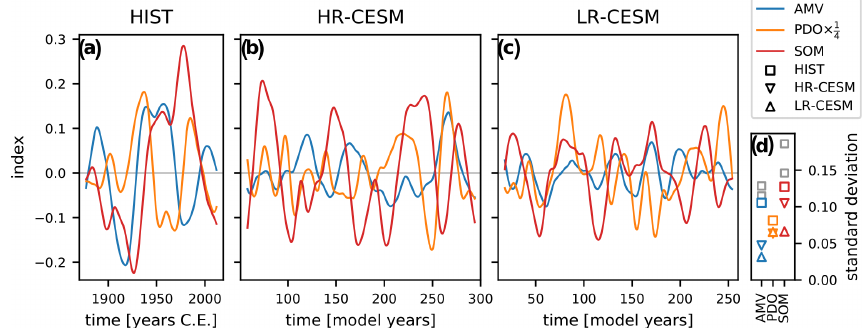
Figure 2. The three 13-year low-pass-filtered indices of multidecadal variability for the two-factor detrended HadISST data (a) and the quadratically detrended HR- (b) and LR-CESM (c) simulations. Atlantic Multidecadal Variability (blue) and Southern Ocean Mode (red) indices are in units of kelvin. The monthly time series of the Pacific Decadal Oscillation index (orange) is dimensionless and has been scaled for a comparable amplitude to the AMV and SOM indices. At each end of the time series, 7 years are removed to avoid filter edge effects. Panel (d) shows the standard deviation of the low-pass-filtered time series derived via stationary bootstrapping. Grey squares indicate the alternative observational SST products COBE-SST2 and ERSSTv5. For the PDO all three are equal; for the AMV and SOM, ERSSTv5 exhibits the highest standard